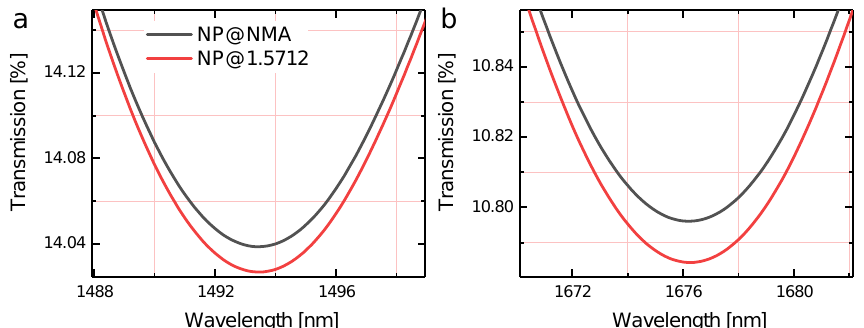
Figure A2. A closer look at the transmission spectra of metasurfaces covered by the NMA layer (black curves) and immersion oil with n av = 1.5712 (red curves) of the same thickness t = 35 nm. The NPs lengths L were chosen to provide for the coincidence of the collective LSPRs of the metasurfaces with the NMA overtone transitions: ( a ) L = 196 nm for N-H band and ( b ) L = 234 nm for C-H band . To keep the collective LSPR of a metasurface in resonance with the chosen overtone transition of